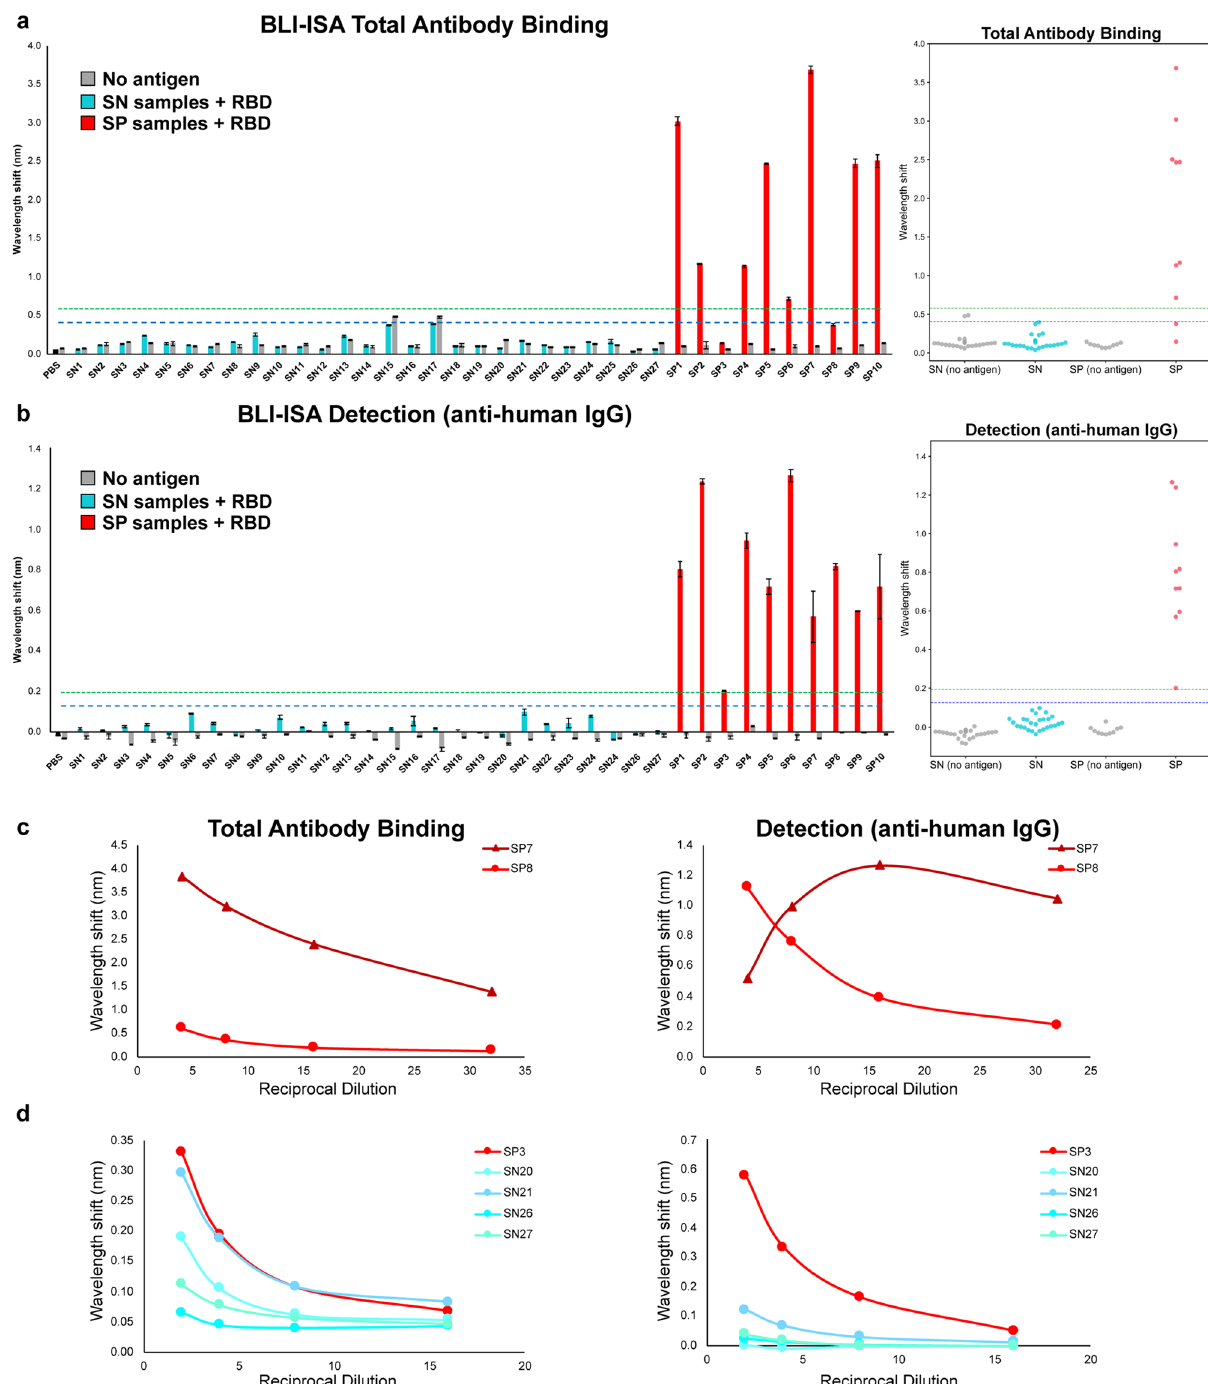
Figure 3. BLI-ISA evaluation of SARS-CoV-2 spike RBD reactivity of pre-pandemic and convalescent plasma. ( a , b ) Single-dilution BLI-ISA to evaluate the presence of RBD-reactive human antibodies in the pre- pandemic seronegative (SN, cyan) and convalescent seropositive (SP, red) samples compared to no-antigen controls (grey). The assays were performed with plasma at a 1:8 dilution. Bars and dots represent the mean of biological duplicates, and error bars represent one standard deviation from the mean. Blue and green dashed lines represent the mean of seronegative samples plus 3 and 5 standard deviations, respectively. ( a ) The Total Antibody Binding signal is measured when RBD-biotin-loaded SA biosensors are dipped into plasma samples. ( b ) The Detection signal is measured when RBD-biotin-loaded SA biosensors that had been dipped into plasma are subsequently dipped into colloidal gold-conjugated anti-human IgG. ( c ) Dilution series BLI-ISA from representative strong (SP7) and moderate (SP8) seropositive samples. ( d ) Dilution series BLI-ISA from the weakest seropositive sample (SP3) compared to seronegative plasma